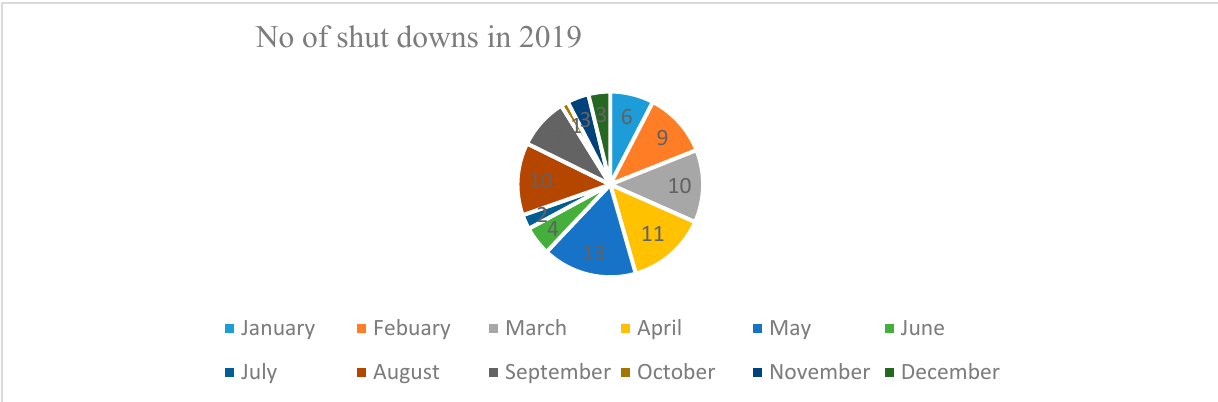
Figure 11. Number of system shutdowns in 2019.